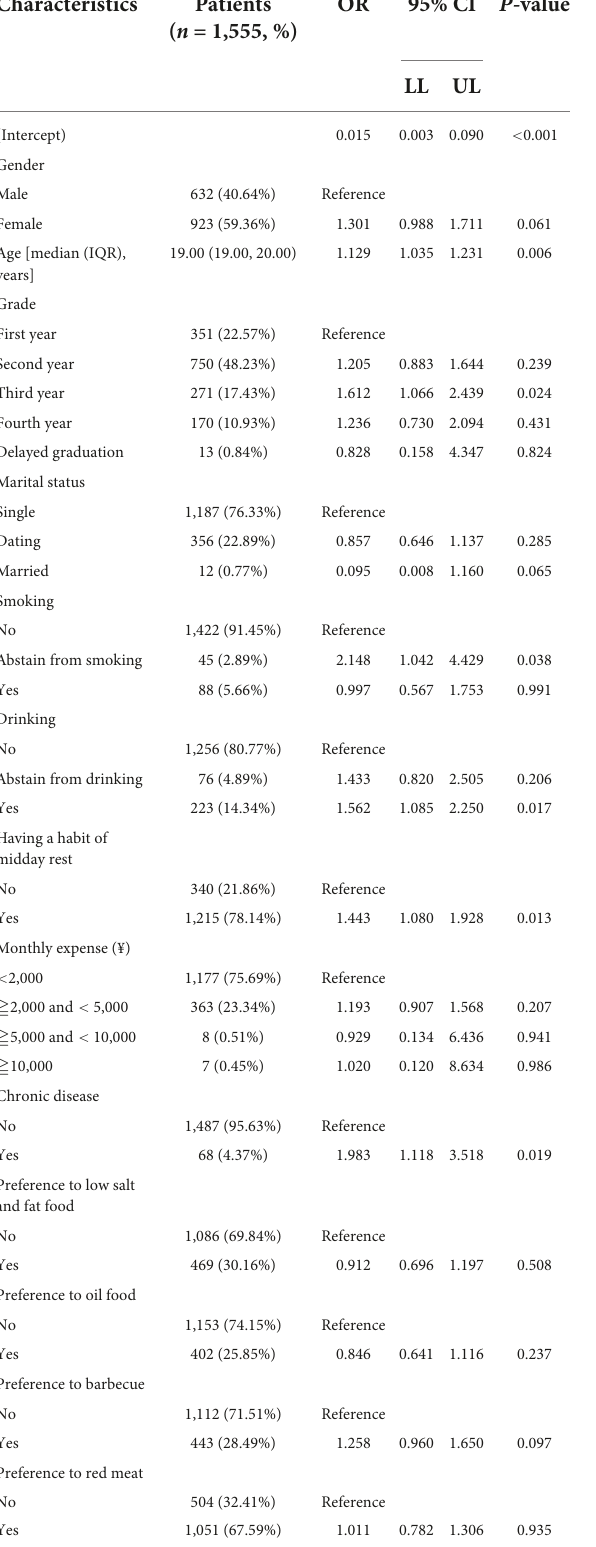
TABLE 2 Multivariate analysis of characteristics for predicting poor sleep quality among university students in the training group.